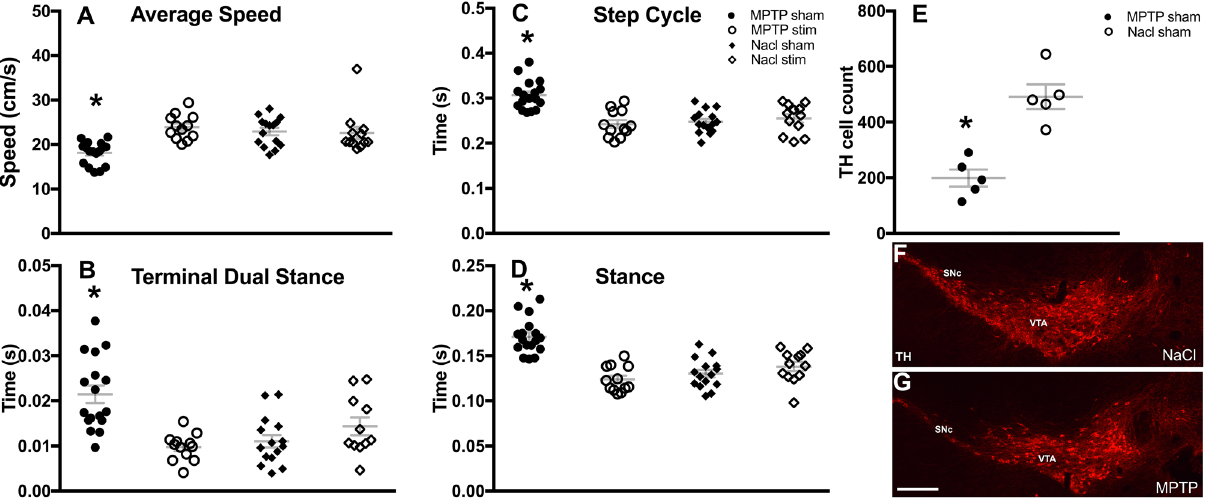
Figure 1. Effect of MPTP treatment and intermittent STN-DBS on Catwalk dynamic and static gait parameters. ( A – D ) Graphs show a significant reduction in speed, and increases of step cycle, terminal dual stance and stance in MPTP-sham mice. STN-DBS restored those parameters to control levels, which is indicated by non- significant differences between MPTP-stim and NaCl-sham groups, and significant differences between MPTP- stim and MPTP-sham groups. ( E ) The graph shows a significant reduction in TH positive cells in the SNc of MPTP-treated mice compared to the NaCl-treated animals. ( F – G ) Representative low-power photomicrograph of coronal brain sections containing the SNc and VTA, stained for TH, show a noticeable TH cell loss in MPTP vs NaCl-treated mice. Data are presented as mean + /− SEM; significant difference ( P < 0.05) is indicated by a “*”, scale bar = 250 µm. Tyrosine hydroxylase, TH; substantia nigra pars-compacta, SNc; ventral tegmental area, VTA; subthalamic nucleus, STN; methyl-4phenyl-1,2,3,6-tetrahydropyridine, MPTP; deep brain stimulation,